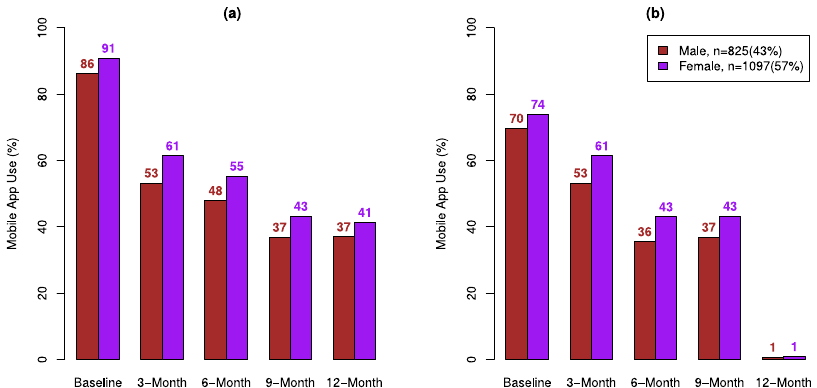
Fig. 2 Smartphone App Use by sex. a Proportions of participants who complete at least one survey at a given 3-month period strati fi ed by sex. b Proportions of participants who complete all surveys at a given 3-month period strati fi ed by